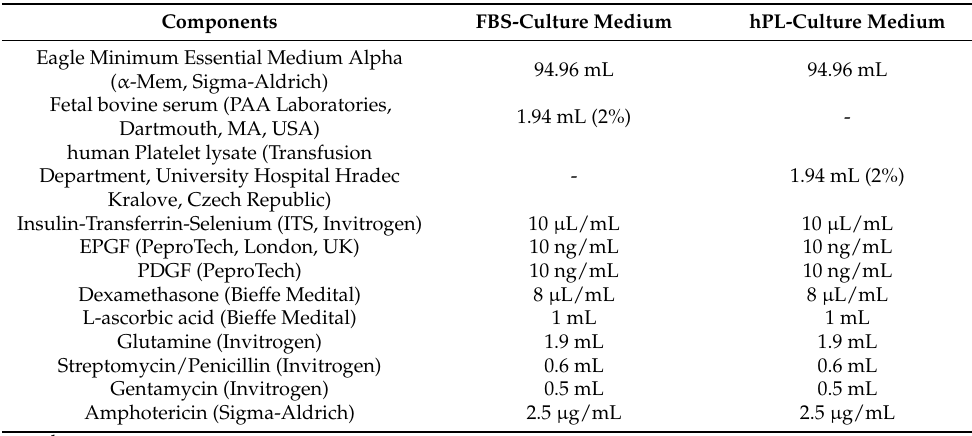
Table 1. Overview of cultivation media